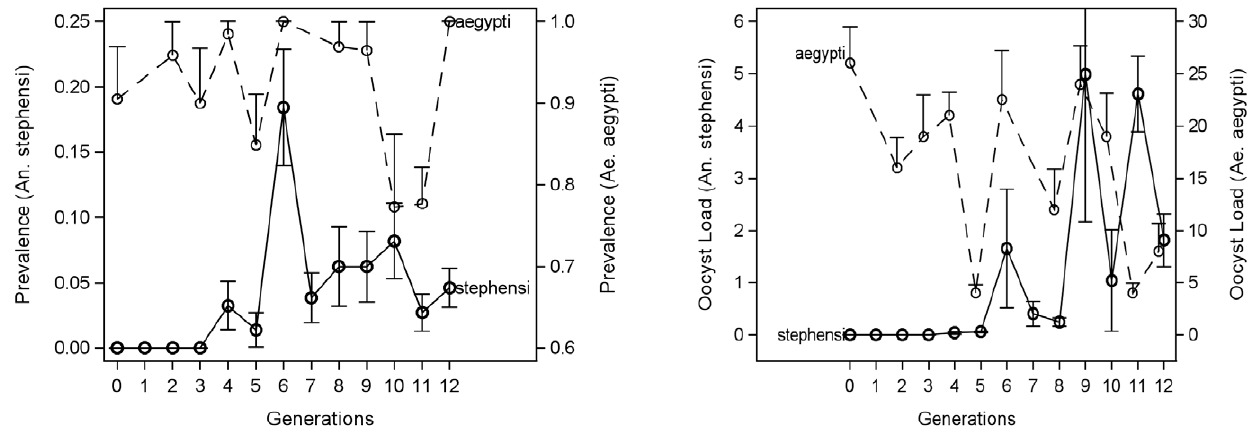
Figure 6. The changes in prevalence and intensity of infection over parasite selection. The changes in the prevalence and mean oocyst load following selection in a line of P. gallinaceum vectored exclusively by An. stephensi compared with that in Ae. aegypti that was simultaneously fed on the same chicken. Note the different Y-axes for the different mosquito species. Prevalence values of An. stephensi were adjusted by the mean prevalence of Ae. aegypti (0.95). Values of oocyst load of An. stephensi were adjusted by the mean oocyst load of Ae. aegypti (19.5). Vertical bars represent SEM (calculated separately for each generation). To avoid clutter, bars representing mean-SEM of Ae. aegypti were excluded.